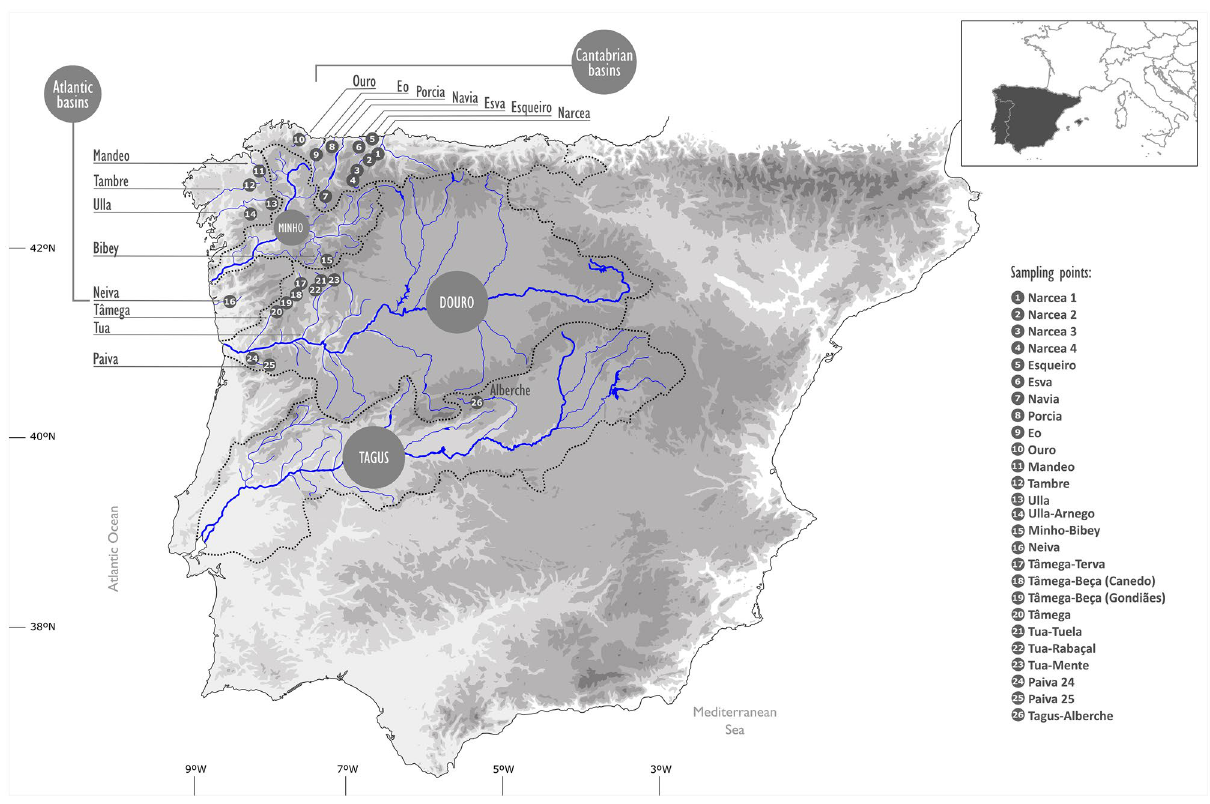
Figure 1. Sample locations for DNA